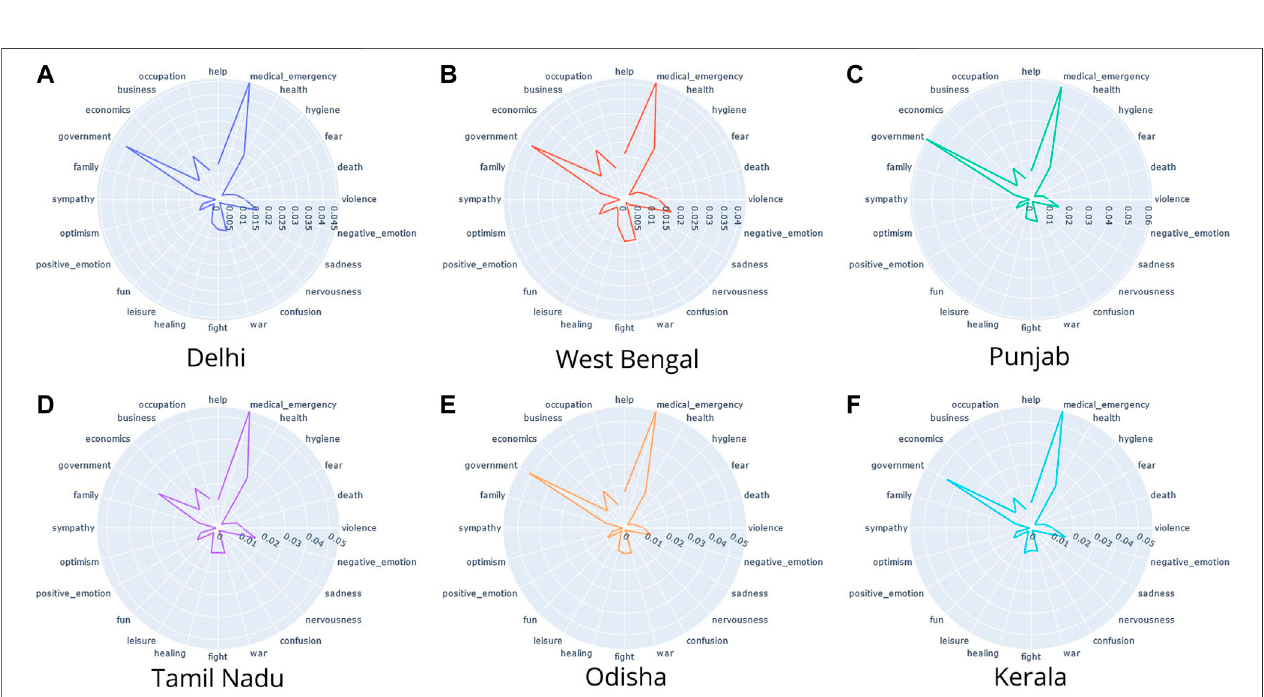
FIGURE 4 | Empath analysis of tweets particular to Indian states: The most prominent categories across all states were medical_emergency and government.